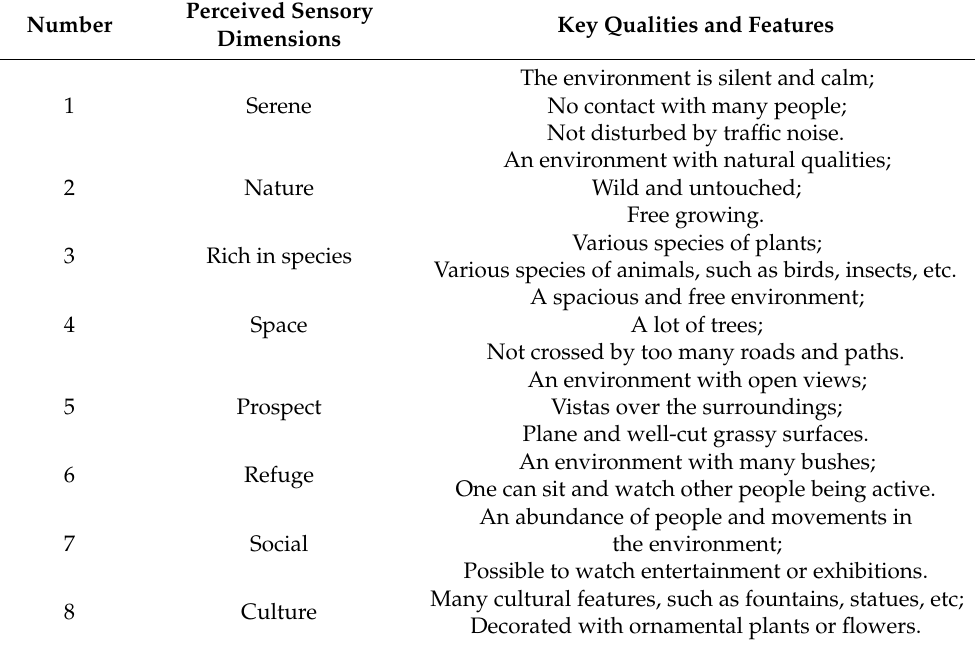
Table 1. Brief descriptions of the eight PSDs (perceived sensory dimensions).